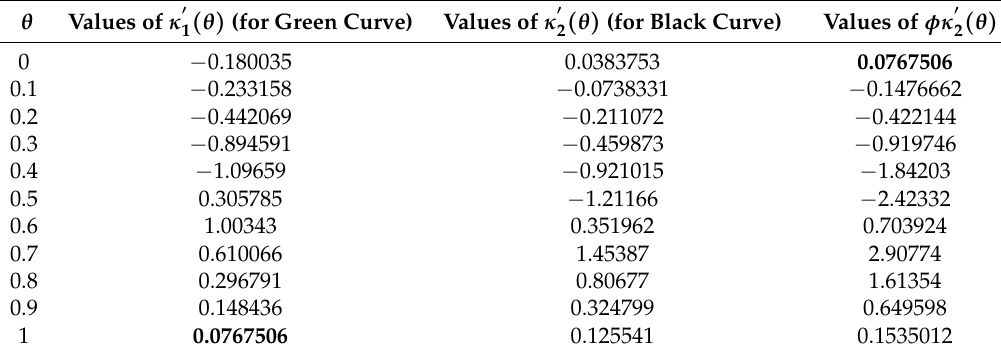
Table 4. Curvature values for G 3 continuity by the GHT Bézier